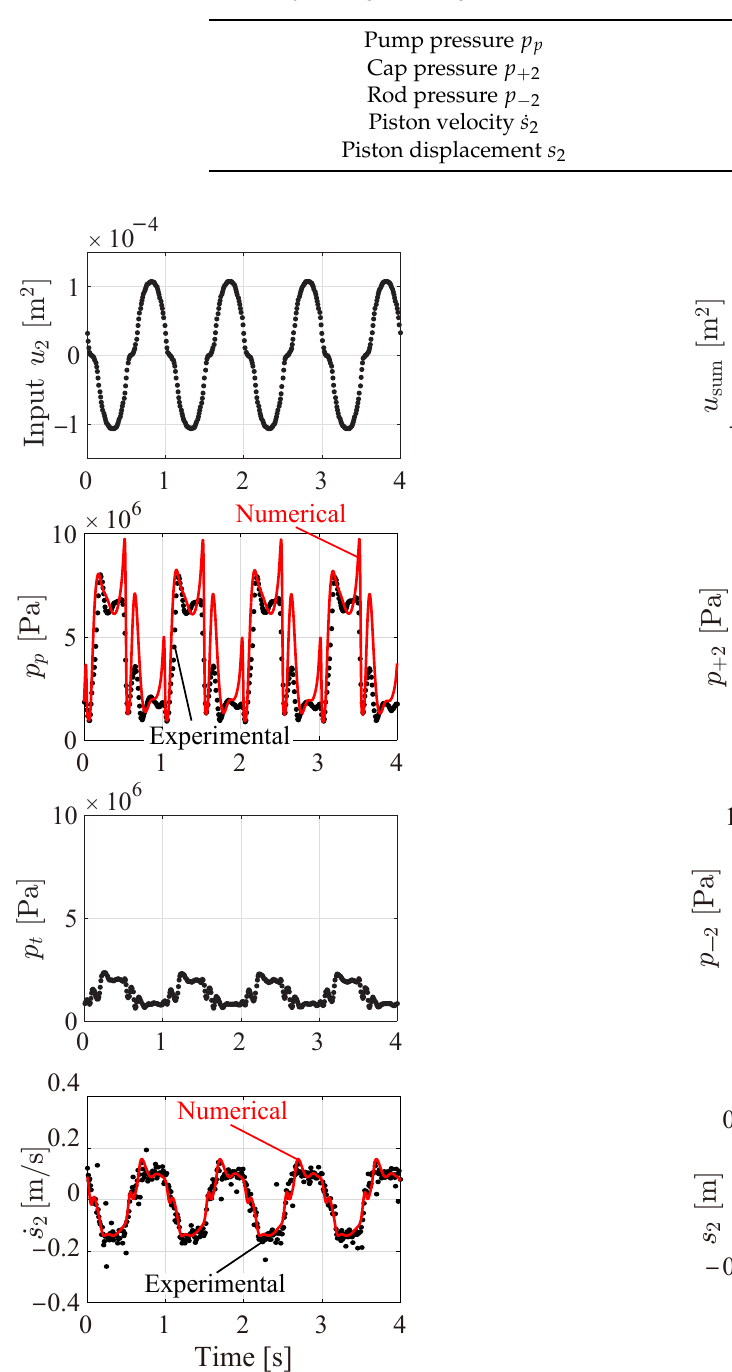
Table 3. The result of cross validation (successfully the fit ratios are positive even though the fit ratio can easily be negative in general).